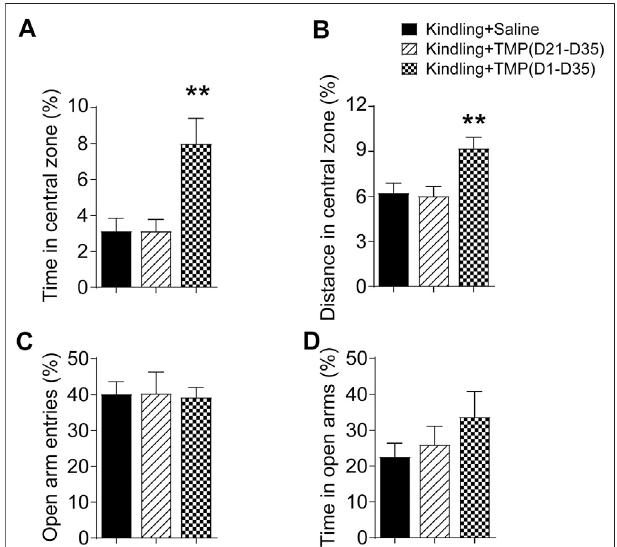
FIGURE 2 | Time dependent effects of TMP on anxiety behaviors in late corneal kindling. (A, B) Effects on time (A) and distance percentage (B) in central zone of open fi eld test with TMP (50 mg/kg, i.p. D21-D35 vs. D1-D35) administration. (C, D) Effects on entries (C) and time percentage (D) in open arms of EPM test with TMP (50 mg/kg, i.p. D21-D35 vs. D1-D35 vs. Saline) administration. Statistical analysis was performed by one way ANOVA, followed by post Dunnett ’ s multiple comparisons (** p < 0.01, vs. Kindling +